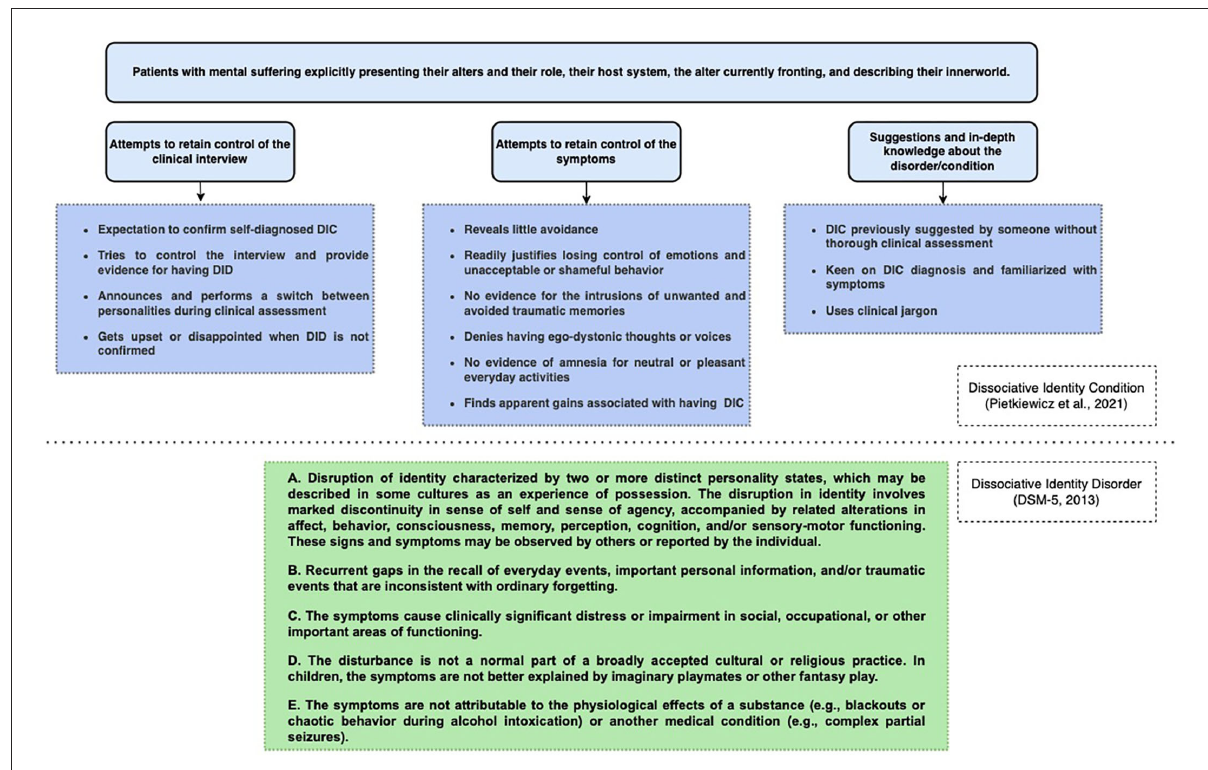
FIGURE1 Details of the three categories allow clinicians to differentiate between the DID describe in the international classifications and the “DID” encountered in clinical practice. Restructured from (6). See Table 2 for the details of the terms used.